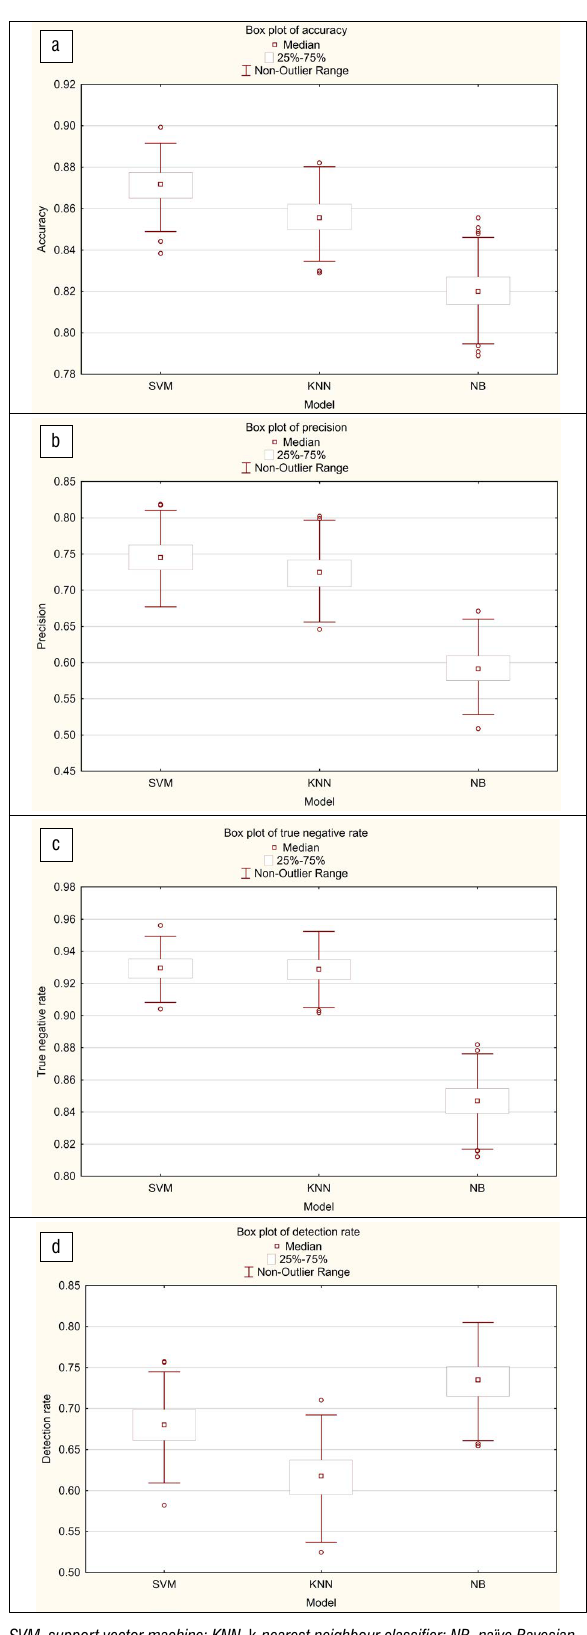
Box plots of classifier comparisons in terms of performance